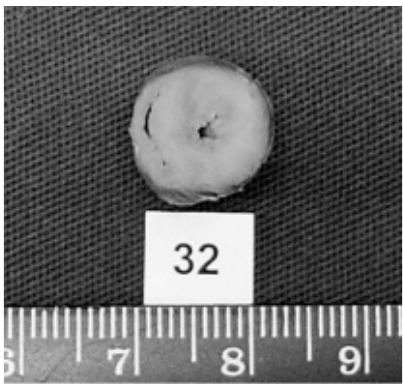
Fig. 7 – Foto de coração de rato submetido à instilação intratraqueal de papaína (grupo P180), demonstrando importante hipertrofia da parede do ventrículo esquerdo e redução da luz da cavidade.